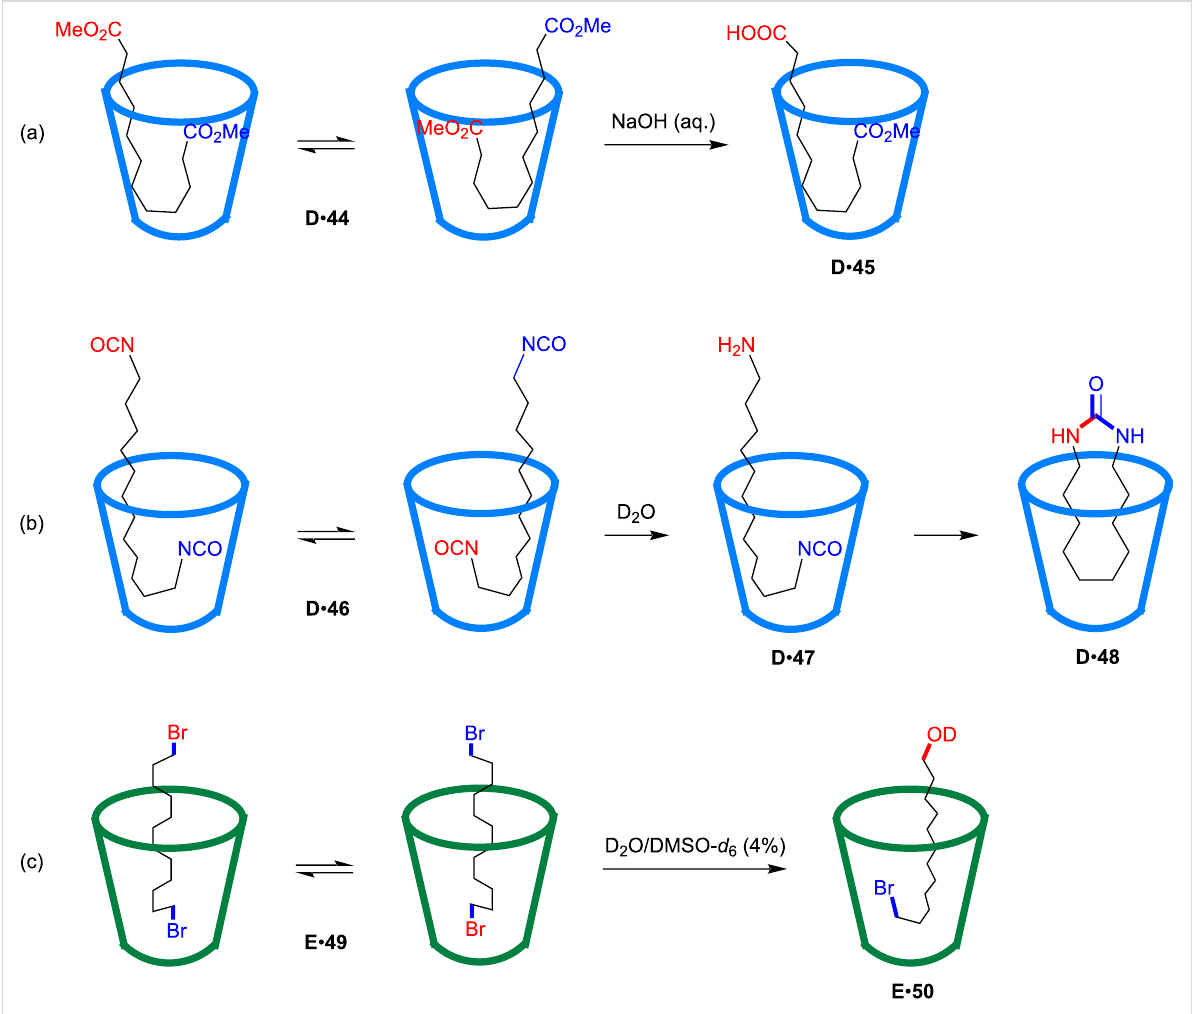
Figure 13: Site-selective monohydrolysis of α , ω -difunctional compounds using deep water-soluble